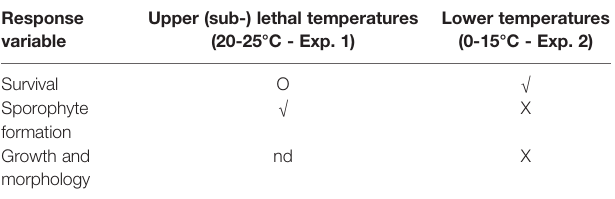
TABLE 5 | Indication of local adaptation in Laminaria digitata gametophyte populations from across the species entire NE Atlantic distribution range with respect to different experimental temperatures and life history